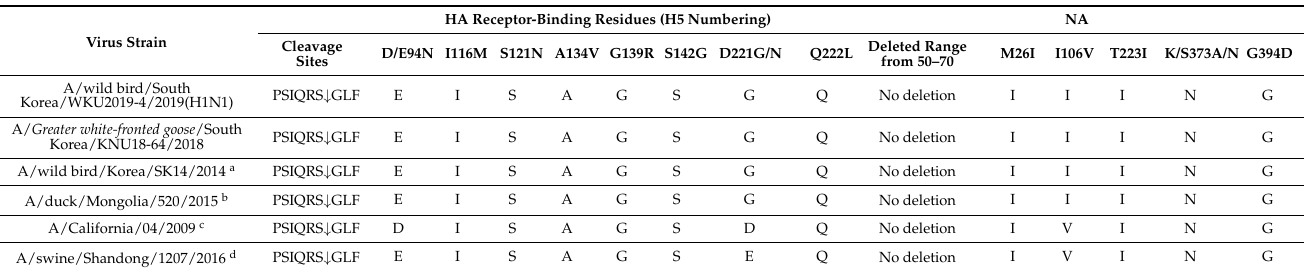
Table 2. Comparison between the hemagglutinin (HA) receptor-binding sites and neuraminidase (NA) of the two novel avian H1N1 isolates and those of human, swine, and avian H1N1 isolates. VirusStrain